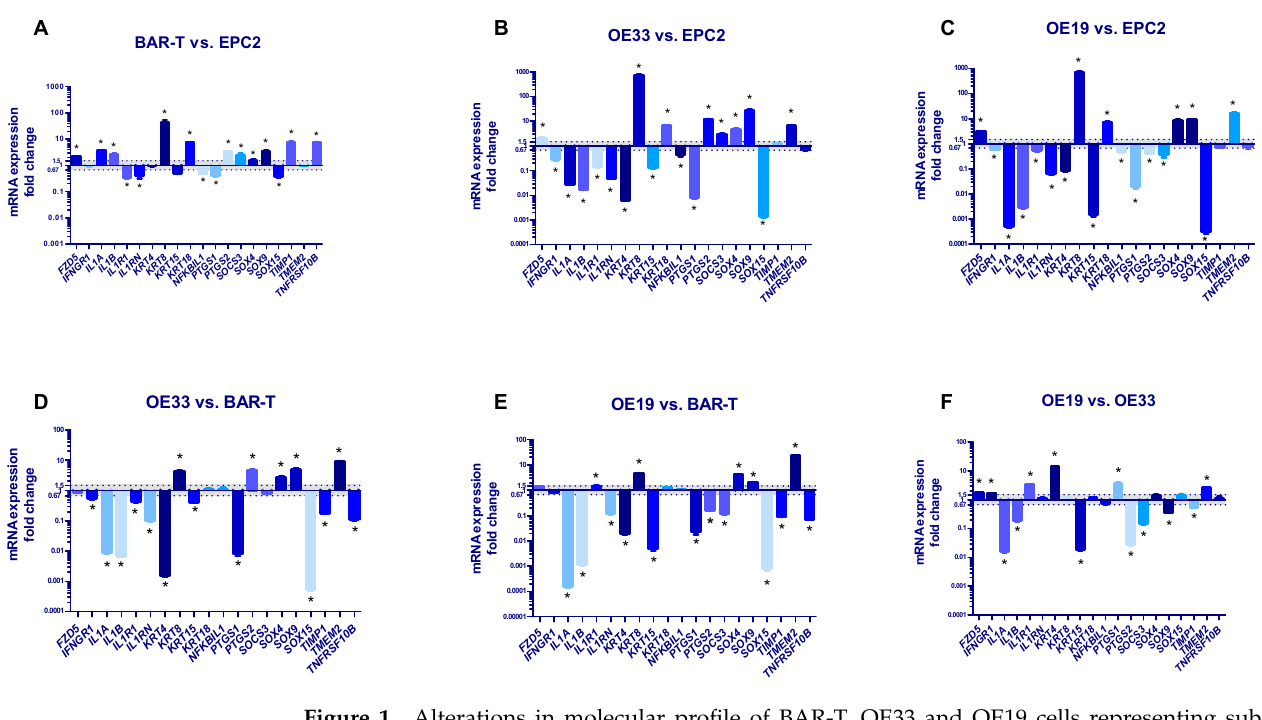
C Figure 2. The viability of cells in different developmental stages of Barrett’s esophagus (BE) and esophageal adenocarcinoma (EAC) exposed to various concentrations of bile mixture (BM) applied in pH 5.0 and pH 7.0. BAR-T ( A ), OE33 ( B ) and OE19 ( C ) were treated for 30 min with 50–1250 μ M of BM. Results are shown as the mean ± SEM. Asterisk (*) indicates a statistically significant difference as compared with respective BM concentration applied in pH 5.0 ( p < 0.05).